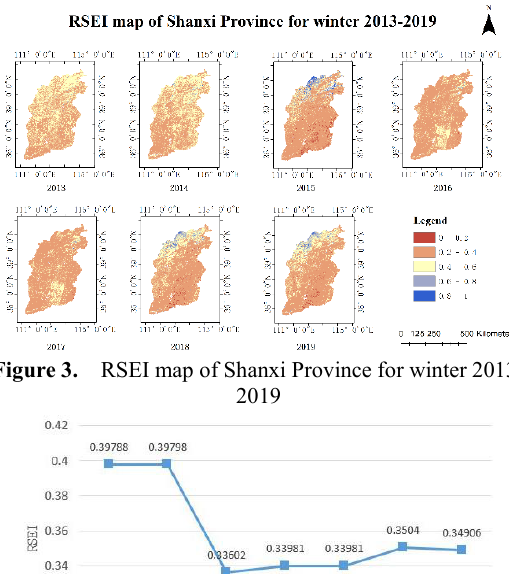
Figure 4. Average curve of RSEI of Shanxi Province for